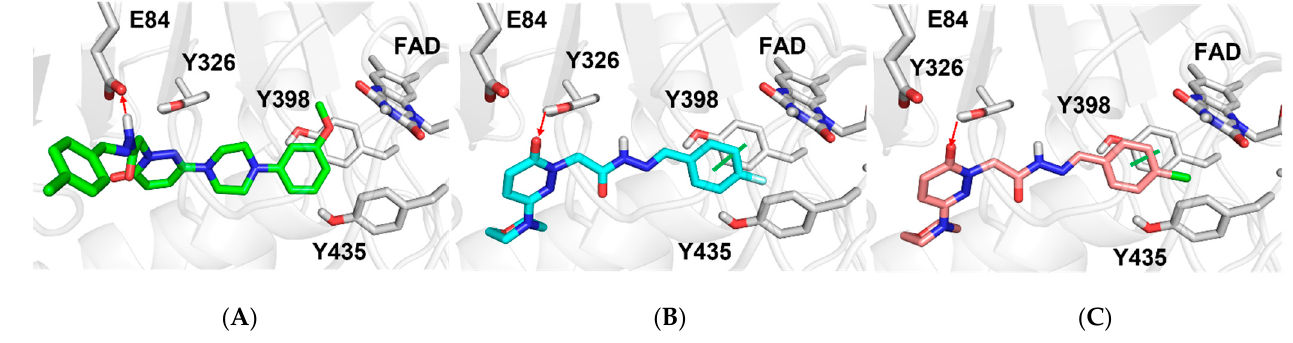
Figure 3. Zoomed in view at MAO-A binding site. Best poses of TR2 ( A ) , TR15 ( B ), and TR16 ( C ) were reported as green, cyan, and magenta sticks, respectively. For completeness, docking scores returned from simulations were equal to − 7.99, − 8.29, and − 8.16 kcal/mol for TR2, TR15, and TR16, respectively.